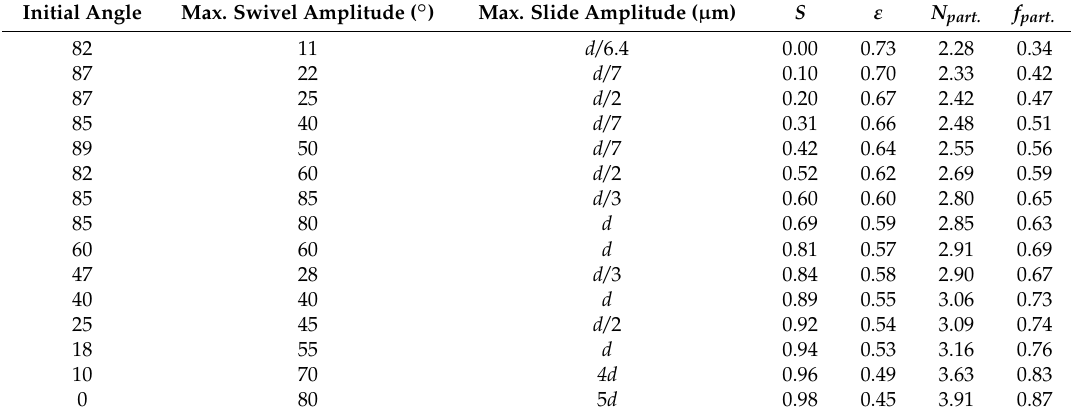
Table 2. Algorithm parameters used to generate the selected 15 simulated disk packings. For each medium, all particles are given an initial angle (in degree) and maximum amplitudes motions to swivel (in degree) and to slide (relative to particle diameter d ) during the settling process. The parameters S and ε stand for the order parameter and the porosity, respectively (uncertainty of ± 0.02). N part. and f part. represent the mean number of particles and the fraction of particles in aggregates, respectively. Initial Angle Max. Swivel Amplitude ( ◦